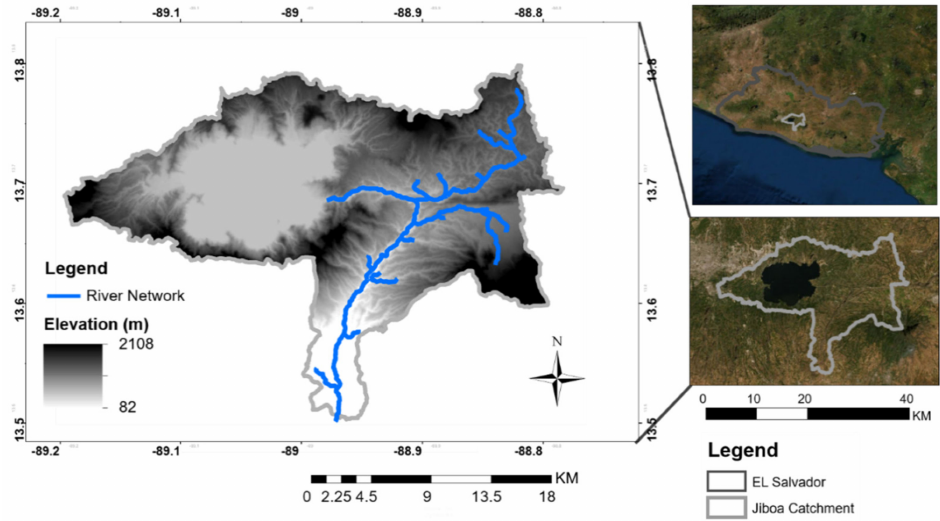
Figure 1. Location map for the Jiboa